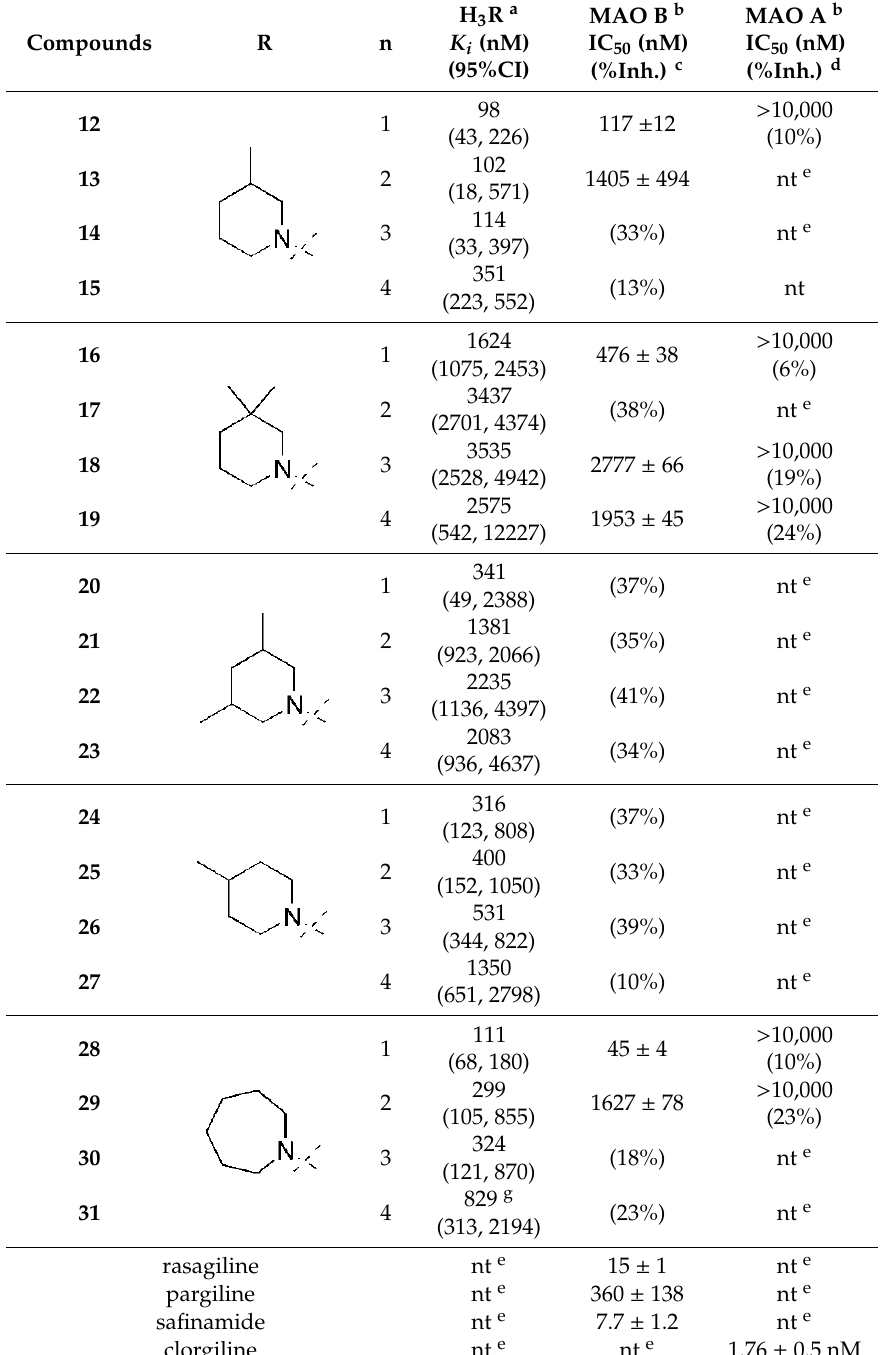
SEM of 2–5 independent experiments; c the percent of inhibition at 1 μ M, mean values of two independent experiments; d the percent of inhibition at 10 μ M, mean values of two independent experiments; e nt = not tested; f K i (± SEM) = 22 ± 3 nM in [ 125 I]Iodoproxyfan binding assay in CHO K1 cells, data from Reference [13]; g data from Reference